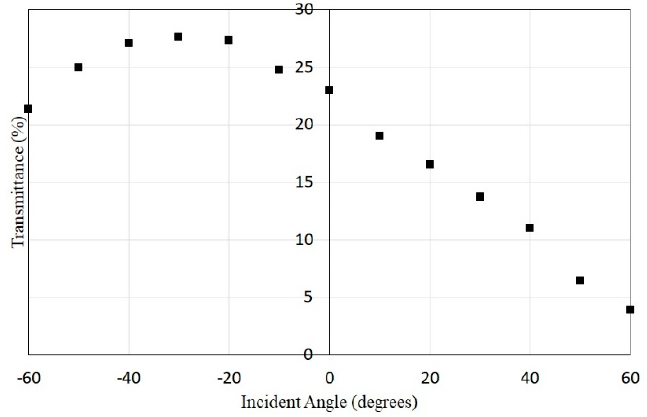
Figure 11. Transmittance dependence on the incident angle for the 2-layer LCD with a 25 ° pretilt angle using a concentration of 1 wt.% NKX-4010 (Hayashibara Ltd., Japan).